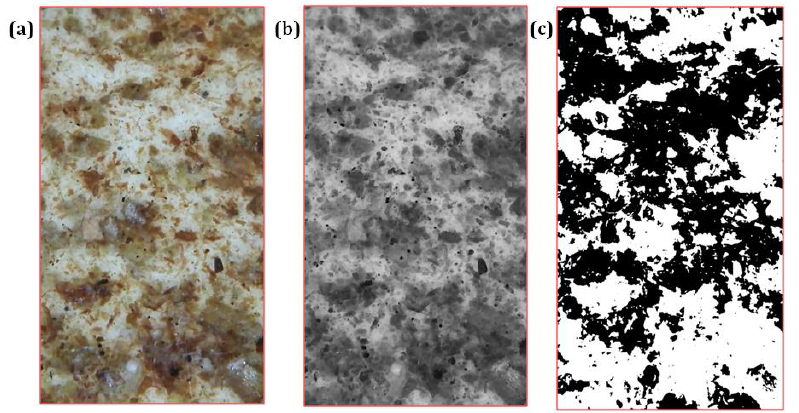
Figure 2. Successive stages of transforming material photos: ( a ) microscopic photo, ( b ) photo after conversion to 8-bit form, ( c ) photo after conversion to binary form.